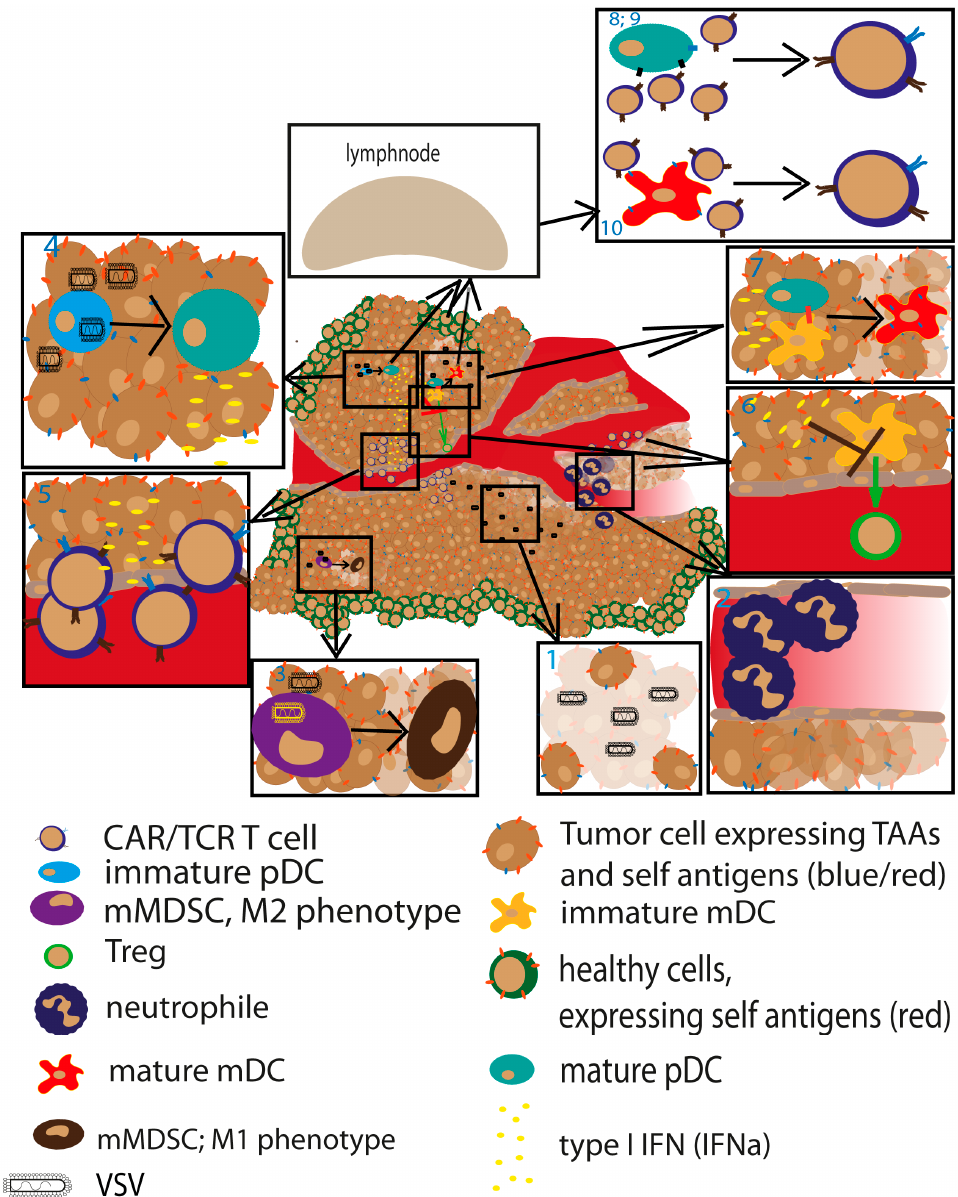
Figure 2. Identification of potential synergistic mechanisms mediated by ACT and VSV. Tumor debulking mediated by VSV potentially synergizes with better response in ACT. Those effects could be mediated by the following mechanisms: ( 1 ). VSV causes potent direct oncolysis to debulk large tumors; ( 2 ). Induction of necrosis by shutdown of tumor vasculature is mediated by attracted neutrophils to site of VSV inflammation; ( 3 ). Monocytic MDSCs (mMDSCs) are matured to a proinflammatory, tumor killing phenotype; ( 4 ). VSV infection causes strong induction of interferon (IFN) type I response by pDC maturation; ( 5 ). This IFN type I response may lead to recruitment of adoptively transferred T cells by chemokine signaling and type II IFN response of natural killer (NK) cells [141–144]; ( 6 ). The type I IFN response to VSV infection may lead to potentially reduced Treg attraction mediated by mDCs [145]; ( 7 ). TLR signaling-matured pDC can activate mDC, which is enhanced by IFN α [146,147]; ( 8 , 9 ). pDC prime a T cell response against viral antigens, as well against tumor antigens introduced to the viral genome [148]; ( 10 ). Matured mDC can take up released tumor antigens from dying tumor cells and prime a T cell response which is enhanced if there is a crosstalk between the dendritic cell subsets [148–150]. Black arrows within the inset boxes indicate differentiation; the green arrow indicates attraction; the T arrow represents inhibition.